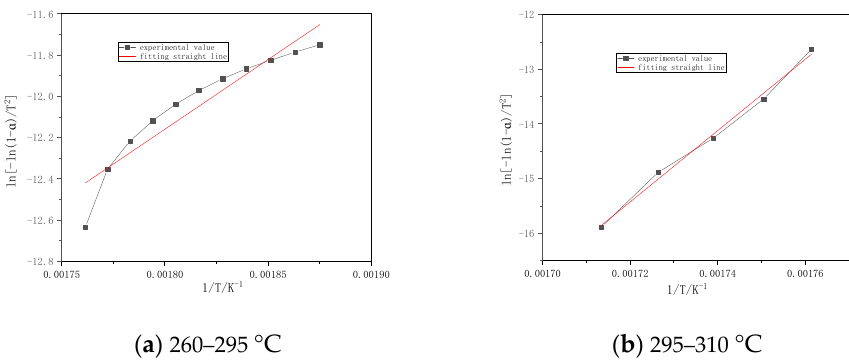
Figure 3. Fitting straight line for burning stages of Chinese fir.